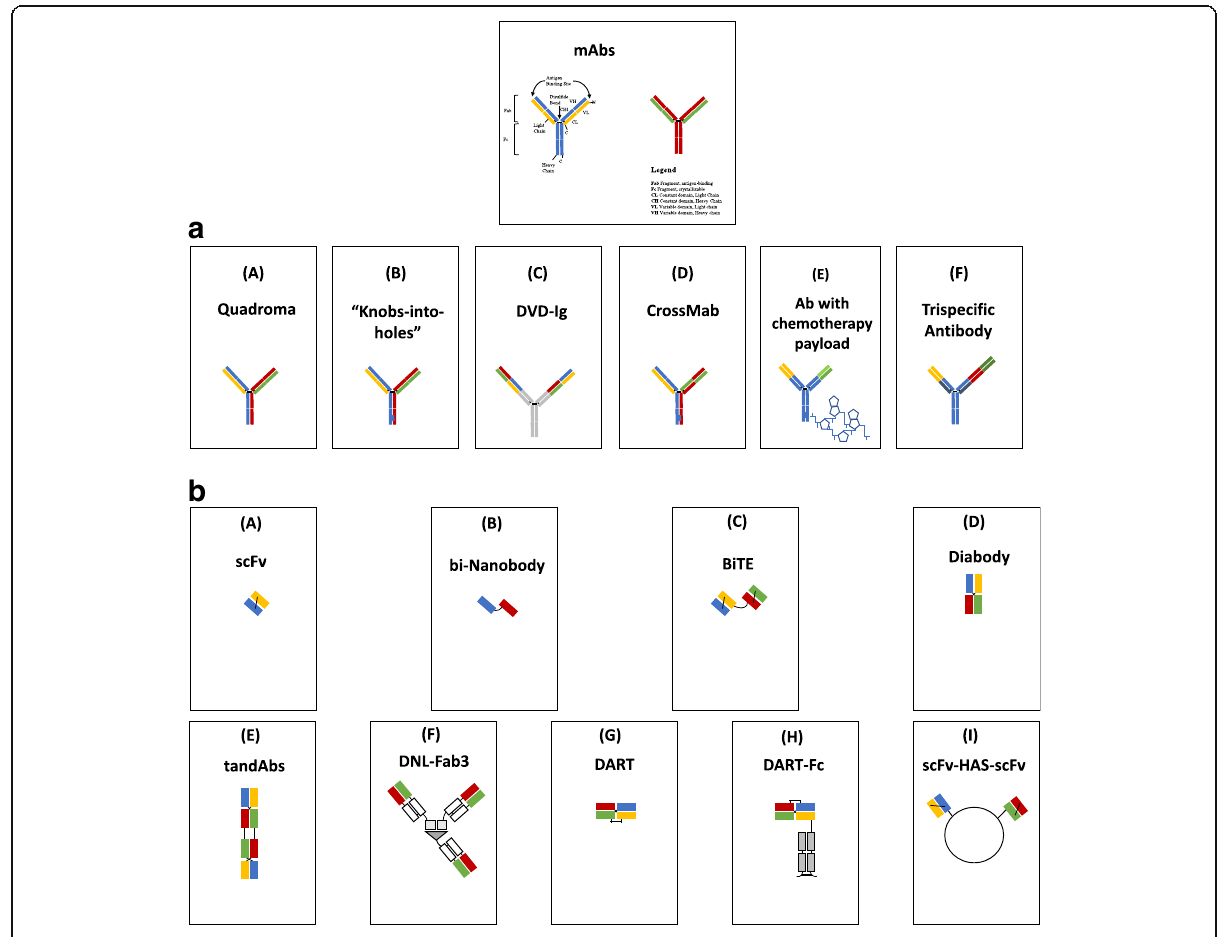
Fig. 1 a : Some formats of IgG – like bispecific antibodies and a trispecific antibody. ( A ) Quadroma created by combining the light and heavy chains of two different monoclonal antibodies resulting in two antigen binding sites aimed at different tumor antigens eg. Catumaxomab ( B ) Two antibody chains with engineered CH3 domain to create a “ knob ” in one heavy chain and a “ hole ” in the other to promote heterodimerization. This allows only specific pairing of heavy chains to reduce mispairing. ( C ) Variable domains of two mABs fused to create a dual- specific antibody ( D ) CrossMab exchanging of the CH1 domain of one heavy chain with the constant domain of the corresponding light chain for better light chain pairing ( E ) Bispecific antibody with two unique antigen-binding sites and a chemotherapy payload attached to the constant domain ( F ) Trispecific antibody engineered to bind to three different ligands on tumor cell. b : Some formats of bispecific antibody fragments and fusion proteins. ( A ) scFvs – Combination of the variable region of one light chain with the variable region of one heavy chain fragment is the basic element for antigen binding. ( B ) bi-Nanobody- Combination of two different single variable heavy chain domains which are able to bind different tumor antigens. ( C ) BiTE- Tandem single chain variable fragments from different antibodies joined by a flexible peptide chain. ( D ) Diabody – Bivalent molecules composed of two chains each comprising a variable light chain and variable heavy chain domain, either from the same or different antibodies. ( E ) TandAbs - Two pairs of variable light chain and variable heavy chain domains are connected in a single polypeptide chain to form a tetravalent tandAb. ( F ) DNL-Fab3 – Trivalent bispecific antibody composed of three Fab fragments joined by the utilization of the specific interaction between the regulatory subunits of cyclic adenosine monophosphate (cAMP)-dependent protein kinase A (PKA) and the anchoring domains of A kinase anchoring proteins (AKAP). ( G ) DART – Two polypeptide chains derived from the variable heavy chain from one molecule linked to a variable light chain of another molecule. ( H ) DART-Fc - DARTs with a Fc fragment designed to prolong serum retention time. ( I ) scFv-HAS-scFV- Association of two single chain variable fragments through modified dimerization